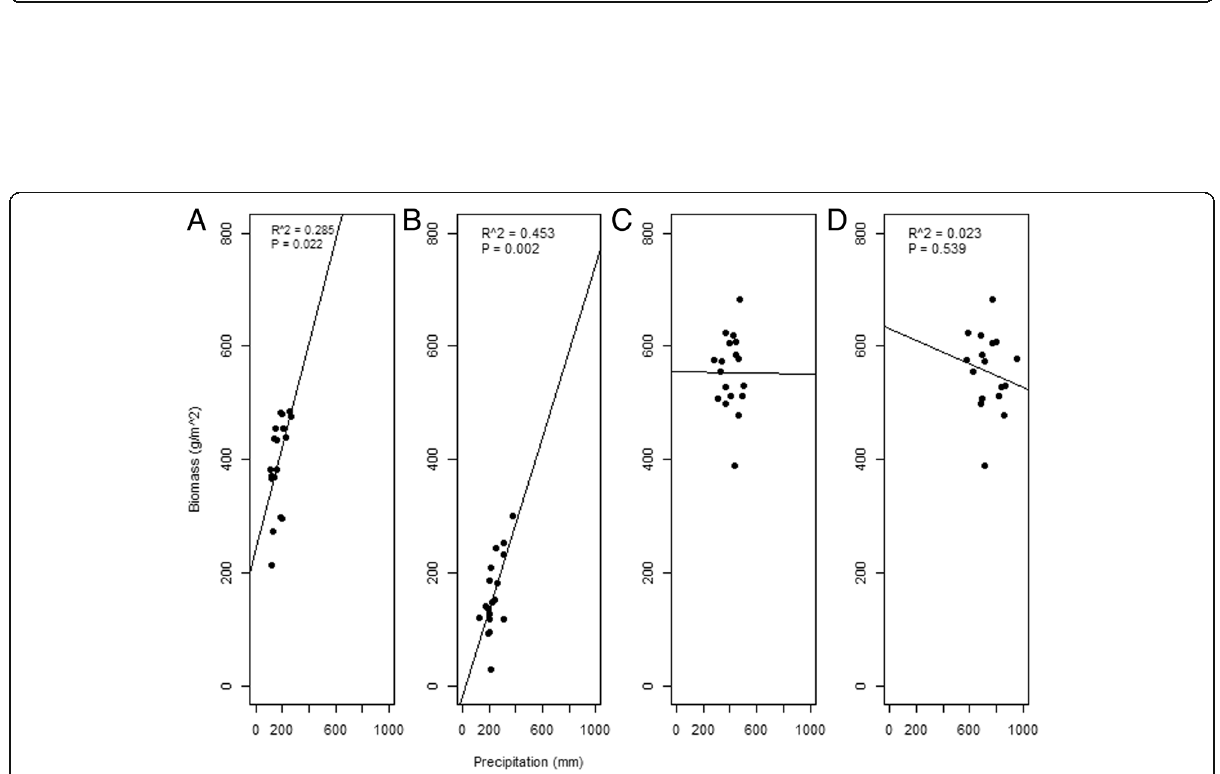
Fig. 5 Response of aboveground biomass productivity to precipitation variability for the study period 1997 – 2015. Relationships of aboveground biomass in June with growing season (March – June) precipitation ( a ), biomass in September with growing season (June – September) precipitation ( b ), annual biomass with growing season (March – September) precipitation ( c ), and annual biomass with annual precipitation ( d )